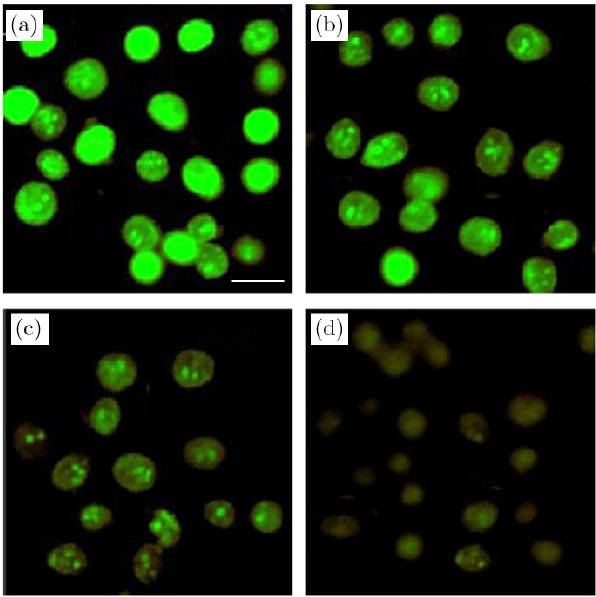
Fig. 9. Composite images of acridine orange/ethidium bro- mide (AO/EB) stained HepG2 cells. (a) control; (b), (c) and (d) — treatment with 0.5, 2.5 and 5 (cid:2) M Photocyanine, re- spectively (original magnification (cid:5) 60, bar ¼ 20 (cid:2) m, AO: green, EB: brown). Reproduced with permission from Ref.